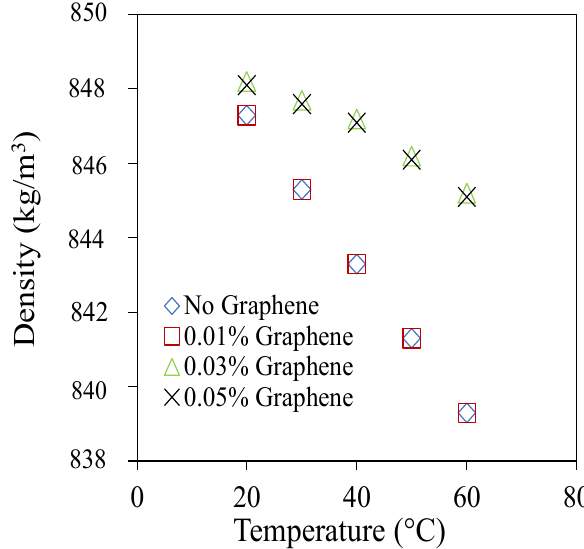
Figure 5. Variation of density of graphene–transformer oil nanofluid with temperature.